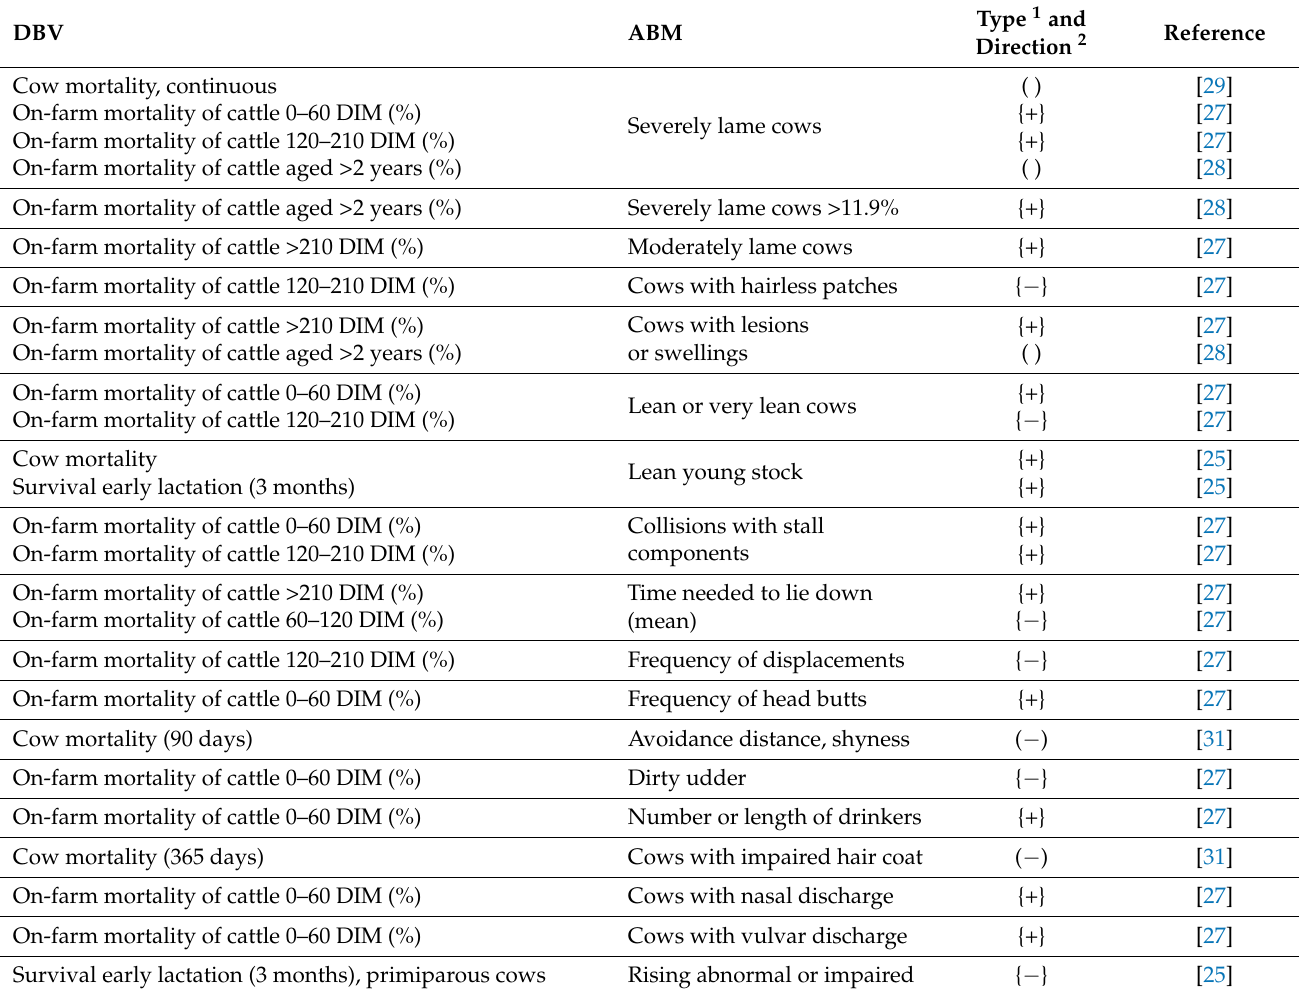
Abbreviations: DIM = days in milk. 1 Type of associations indicated by ( ) for univariable associations and { } for multivariable associations. 2 Direction of associations indicated by + for positive associations and − for negative associations, empty brackets indicate that no